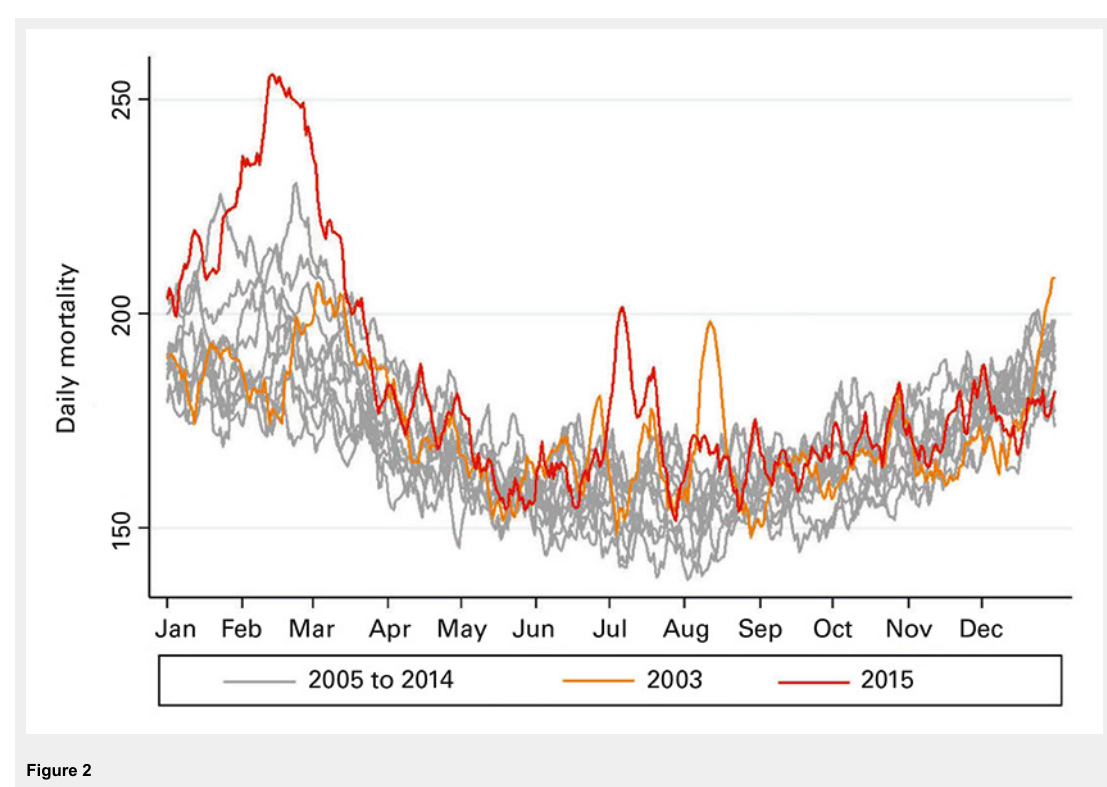
Figure 2 All-cause daily mortality (number of deaths) in Switzerland in 2003, from 2005 to 2014 and in 2015.